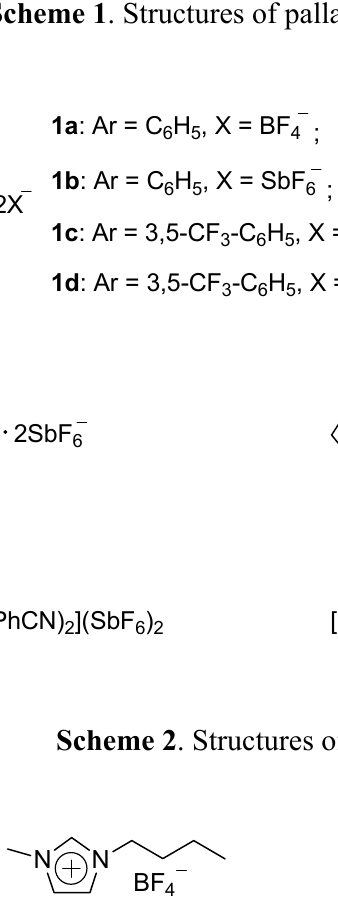
Scheme 1 . Structures of palladium(II) complexes.